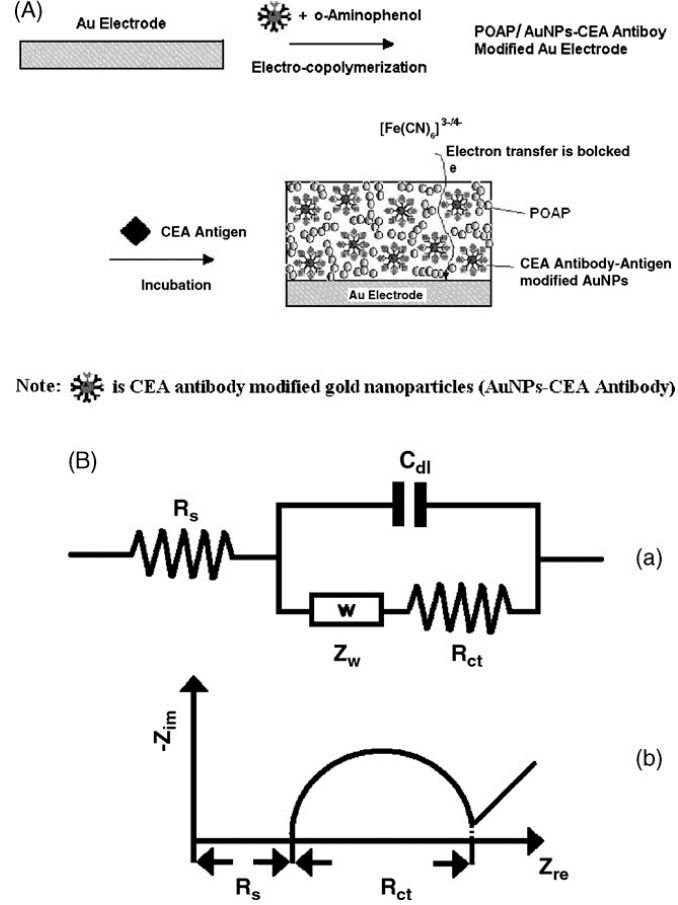
Figure 8. ( A ) Scheme for the electro-copolymerization of CEA antibody–AuNP bioconjugates with o-aminophenol on polycrystalline gold electrode and the formation of CEA antibody–antigen complexes. ( B ) Scheme for general equivalent circuit for impedance spectra analysis in the presence of a redox probe ( a ) and a typical Nyquist plot of an electrochemical impedance spectra ( b ) [85] Copyright 2006. Reproduced with permission from Elsevier